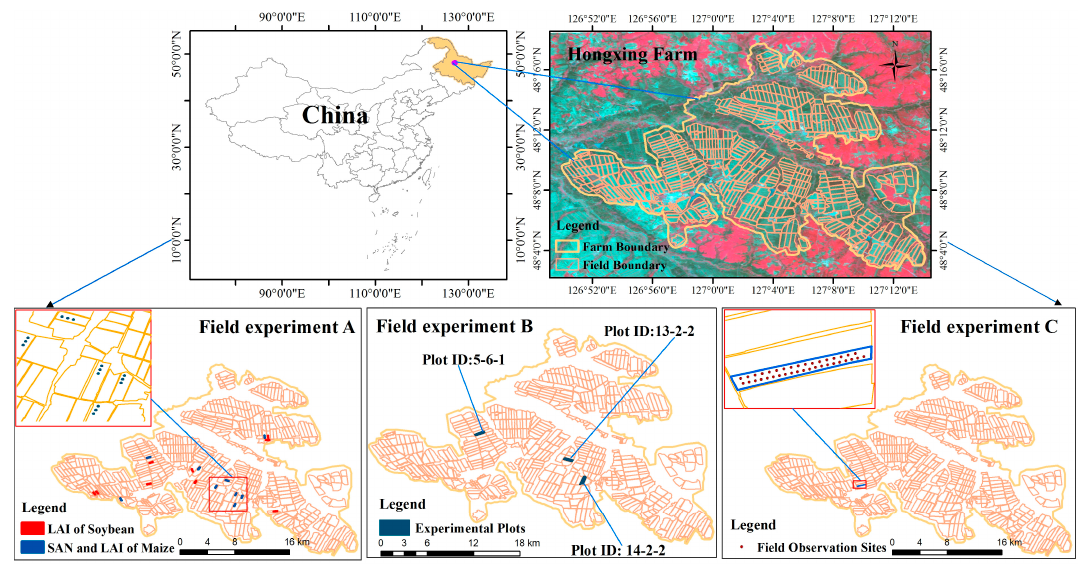
Figure 1. Location of Hongxing Farm and the field campaign sites (The location of LAI quadrats in field experiment A is the first one of five sequential field campaigns).